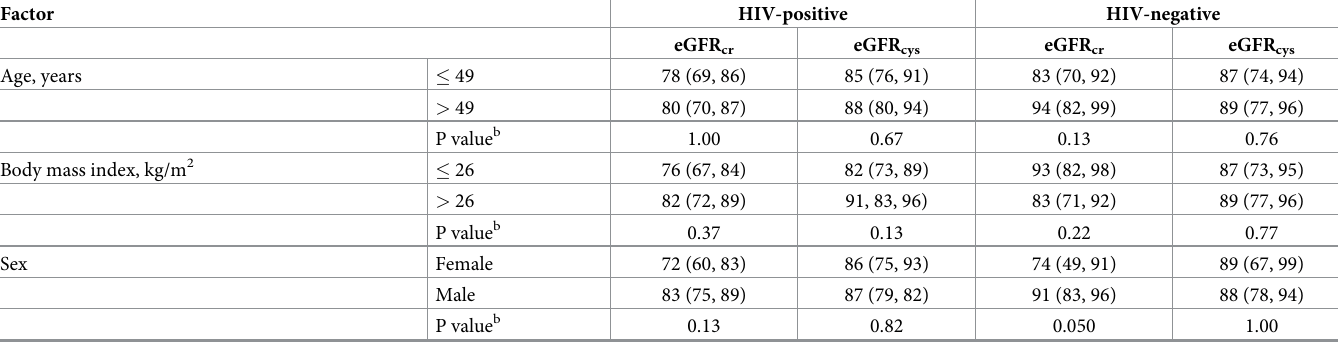
Table 3. Factors associated with glomerular filtration rate estimating equation accuracy a in HIV-positive and HIV-negative participants.